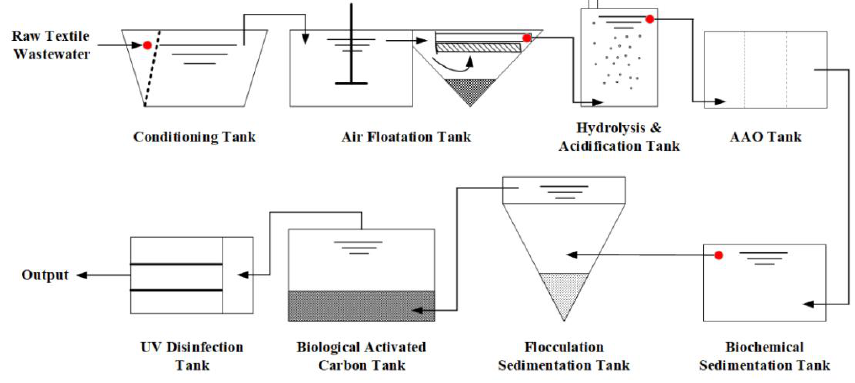
Figure 4. Existing textile wastewater treatment process.